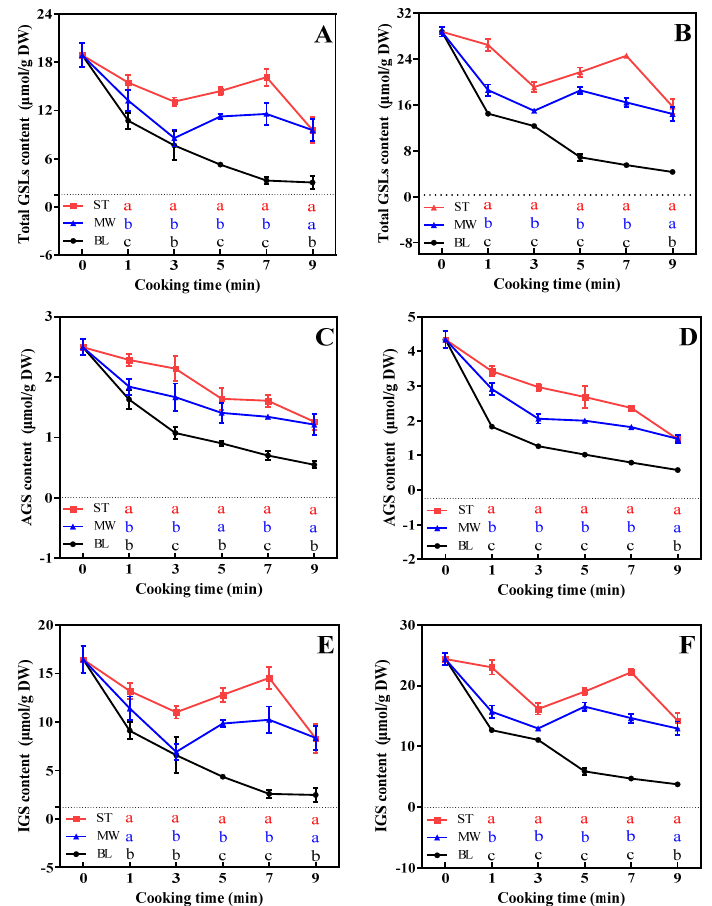
Figure 4. Effects of cooking method on GSL content in broccoli florets. Total GSL content (( A ): Yanxiu, ( B ): Xianglv No.3), total AGS content (( C ): Yanxiu, ( D ): Xianglv No.3), total IGS content (( E ): Yanxiu, and ( F ): Xianglv No.3). Red lines, steaming, blue lines, microwaving; black lines, boiling. Error bars represent SD from three replications of under every treatment under cooking experiment. Different letters indicate statistically significant differences among treatments ( p < 0.05).